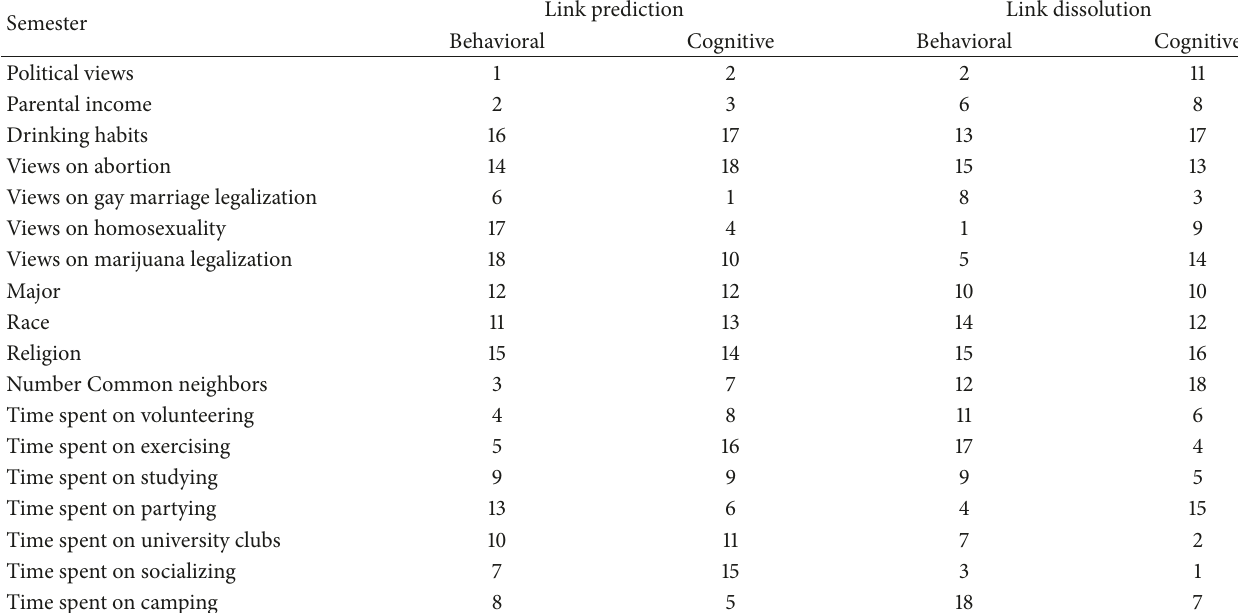
Table 5: Ranks of different